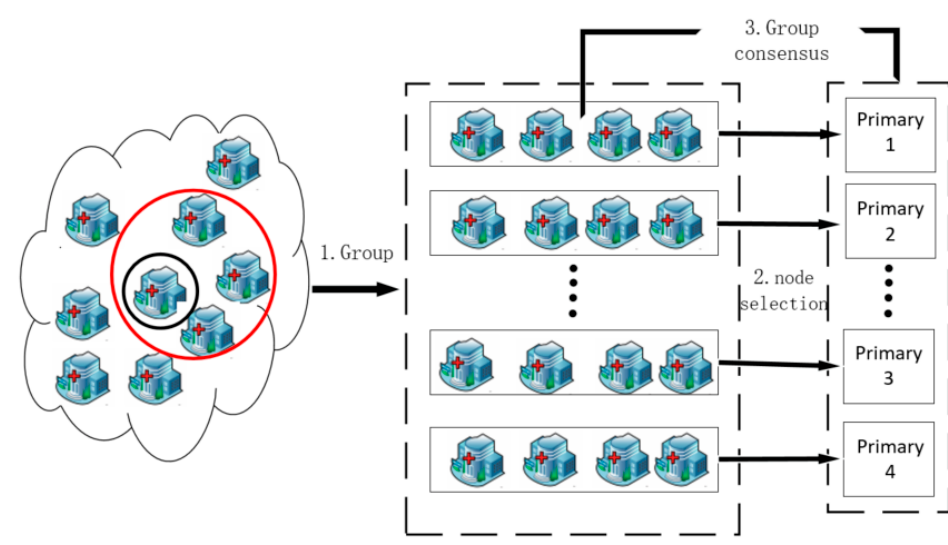
Figure 4. Consensus model diagram of the medical data storage blockchain.